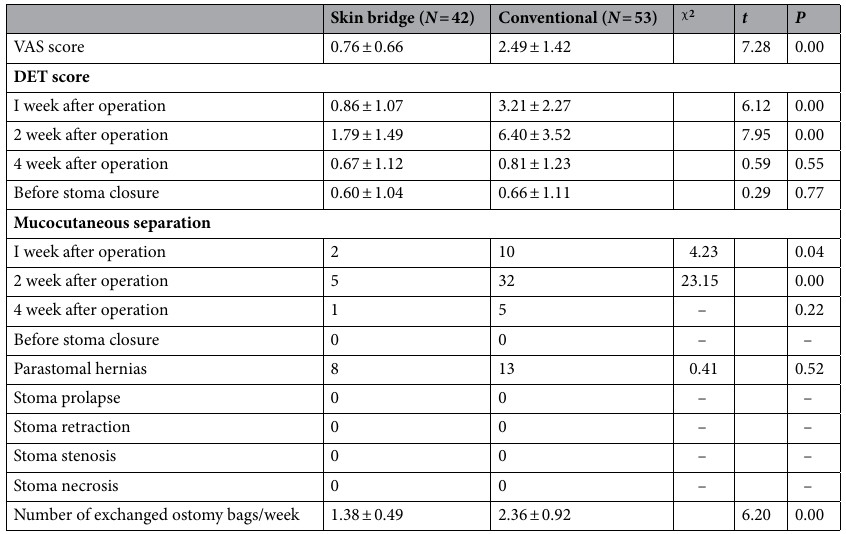
Table 2. Stoma-related complications and number of weekly exchanged ostomy bags of creation of skin bridge versus conventional